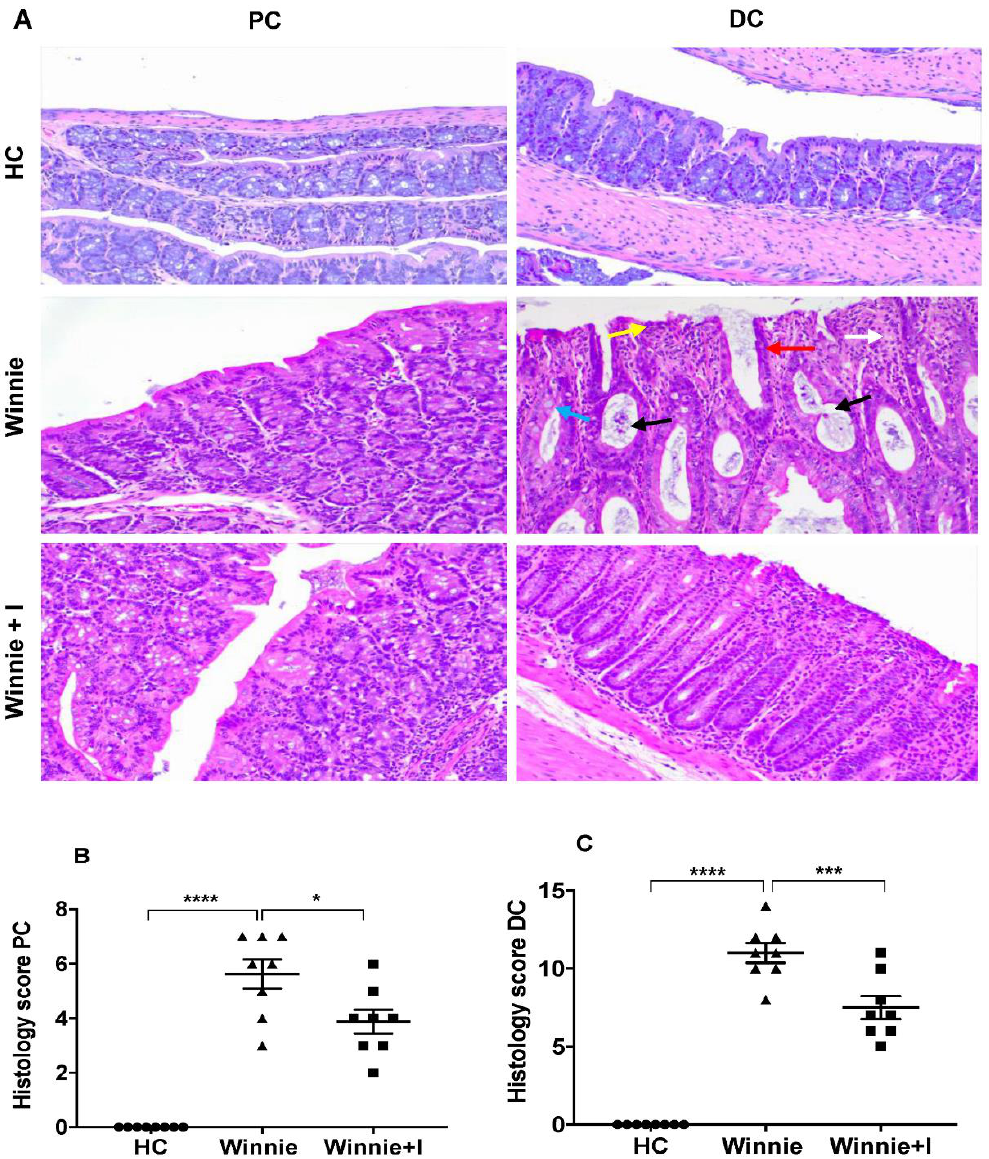
Figure 2. Effect of idebenone on histopathology in the Winnie model of spontaneous chronic colitis. ( A ) Representative histological images of proximal (PC) and distal colon (DC) stained with hematoxylin and eosin (H&E) from healthy control C57BL/J6 mice (HC), untreated Winnie mice (Winnie) and Winnie mice treated with idebenone (Winnie + I) at 20× magnification. ( B ) and ( C ) Comparison of histology scores for each group in PC and DC. Data expressed as mean ± SEM ( n = 8/group). Statistical significance among groups was evaluated by One-way ANOVA followed by Tukey’s post-test. * p < 0.05 , *** p < 0.001 and **** p < 0.0001. Arrows indicate goblet cells loss (blue), crypt abscesses (black), crypts loss/crypts distortion (red), inflammatory cell infiltration (white) and epithelial surface erosion (yellow).